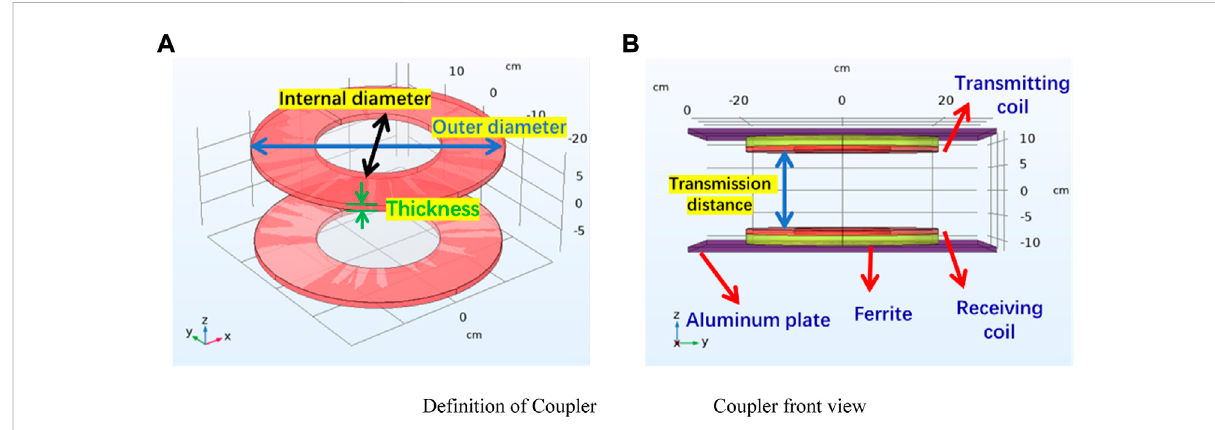
FIGURE 1 Three-dimensional structure of the coupler. (A) De fi nition of the coupler. (B) Front view of the coupler.